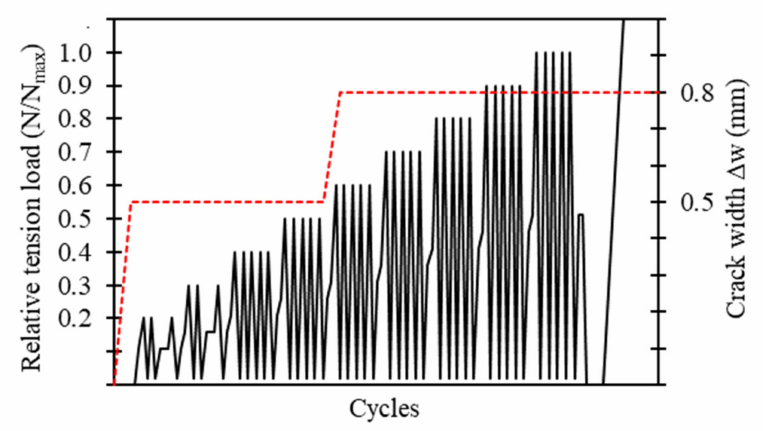
Figure 2. Schematic test procedure for pulsating tension load tests in test series C2.3. Redrawn on the basis of EOTA TR 049